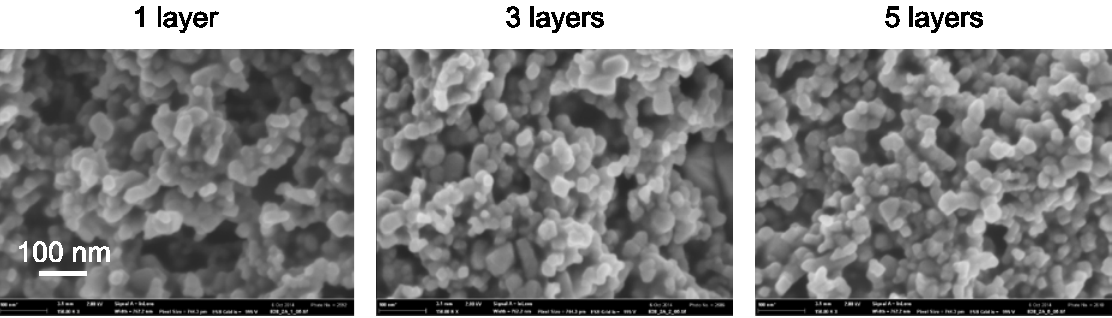
Figure 6. Flattening surface topology of sintered Ti_3 sample set with increasing number of printed layers as seen by